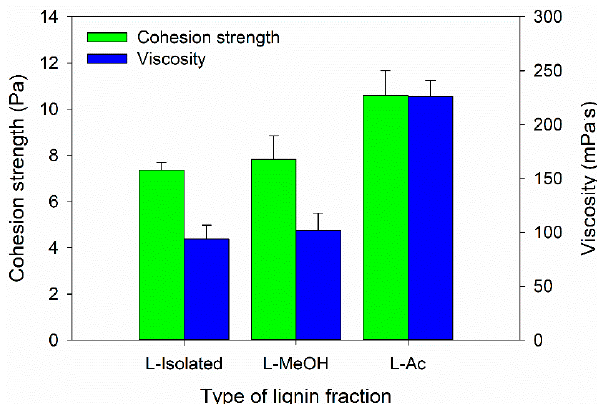
Figure 7. Viscosity and cohesion strength of Bio ‐ PU from fractionated lignin.